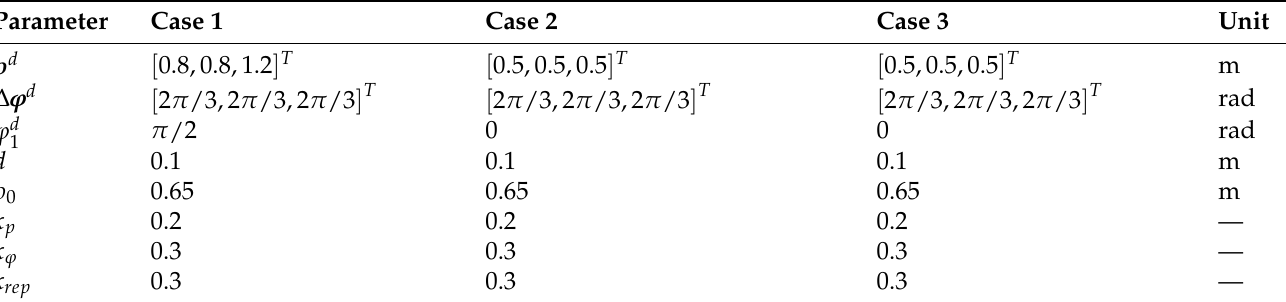
Table 2. The parameters of three groups of